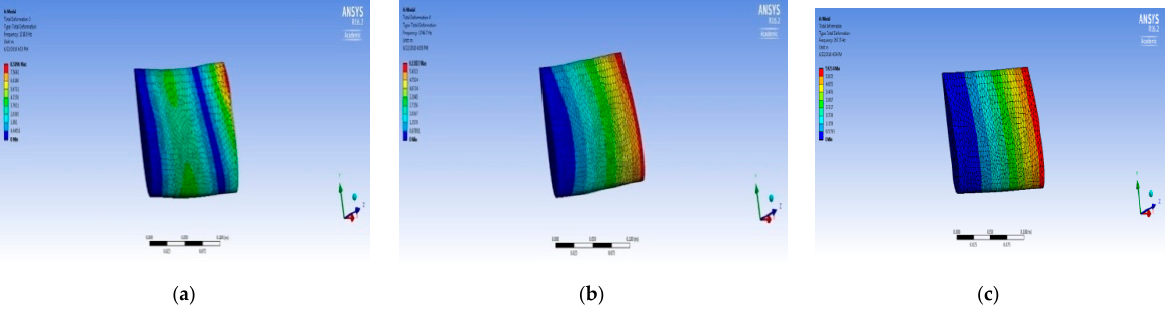
Figure 23. Deformed structures of GFRP, KFRP, and CFRP, respectively. ( a ) Vibrational displacements of UAV wing imposed with GFRP. ( b ) Vibrational displacements of UAV wing imposed with KFRP. ( c ) Vibrational displacements of UAV wing imposed with CFRP.